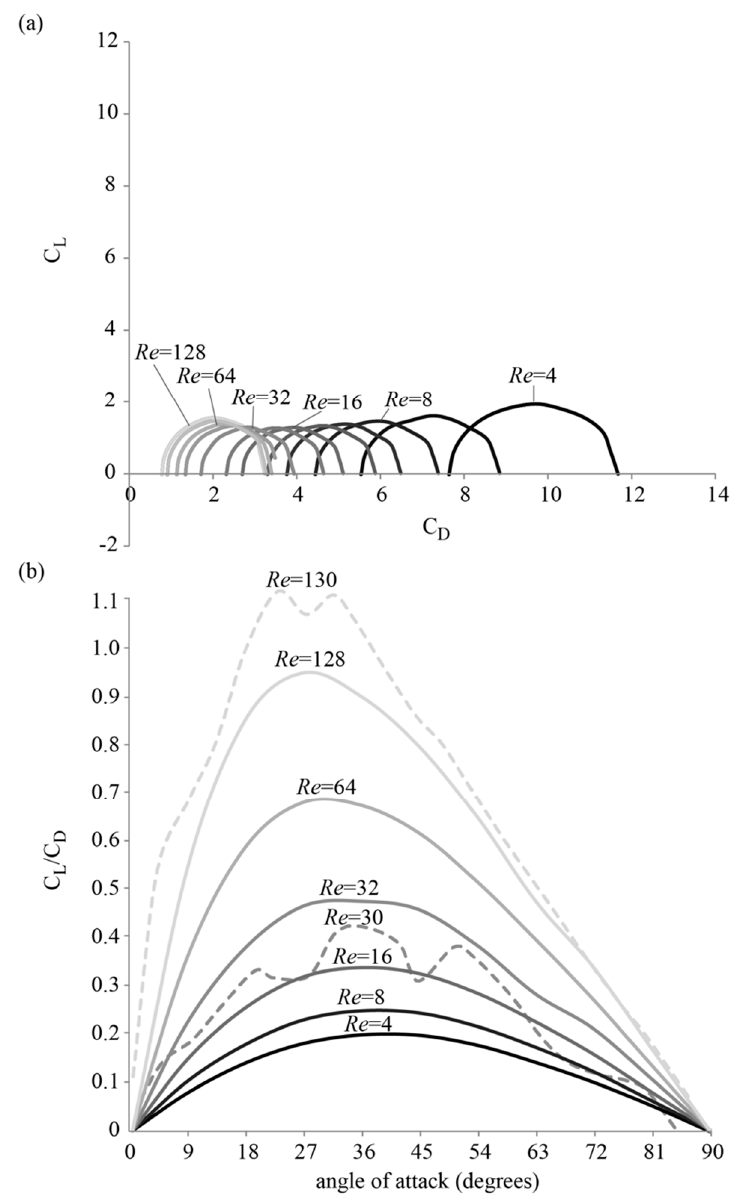
Figure 5. ( a ) The plot of average dimensionless lift versus average dimensionless drag for over a range of Re . In all cases, peak lift occurs at an angle of attack of 45°; ( b ) The plot of the ratio of lift to drag versus angle of attack over a range of Re . Numerical results are shown by solid lines and experimental results by dashed lines.